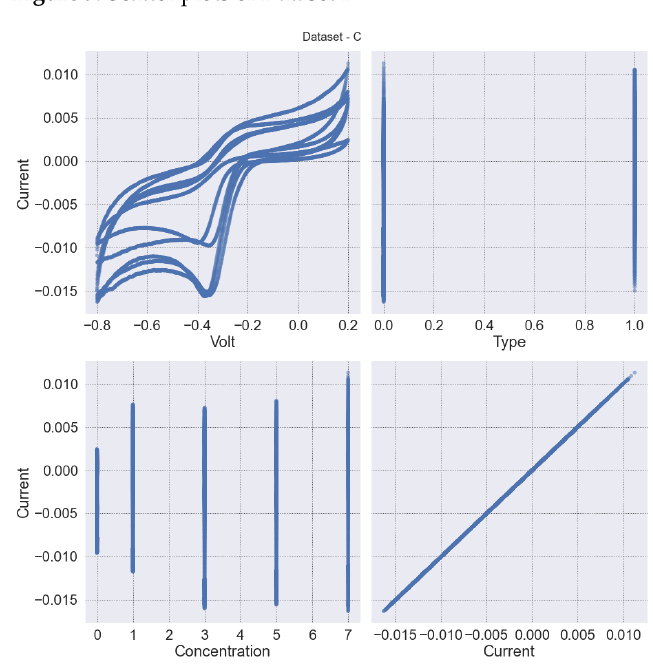
Figure 10. Scatter plots of Dataset